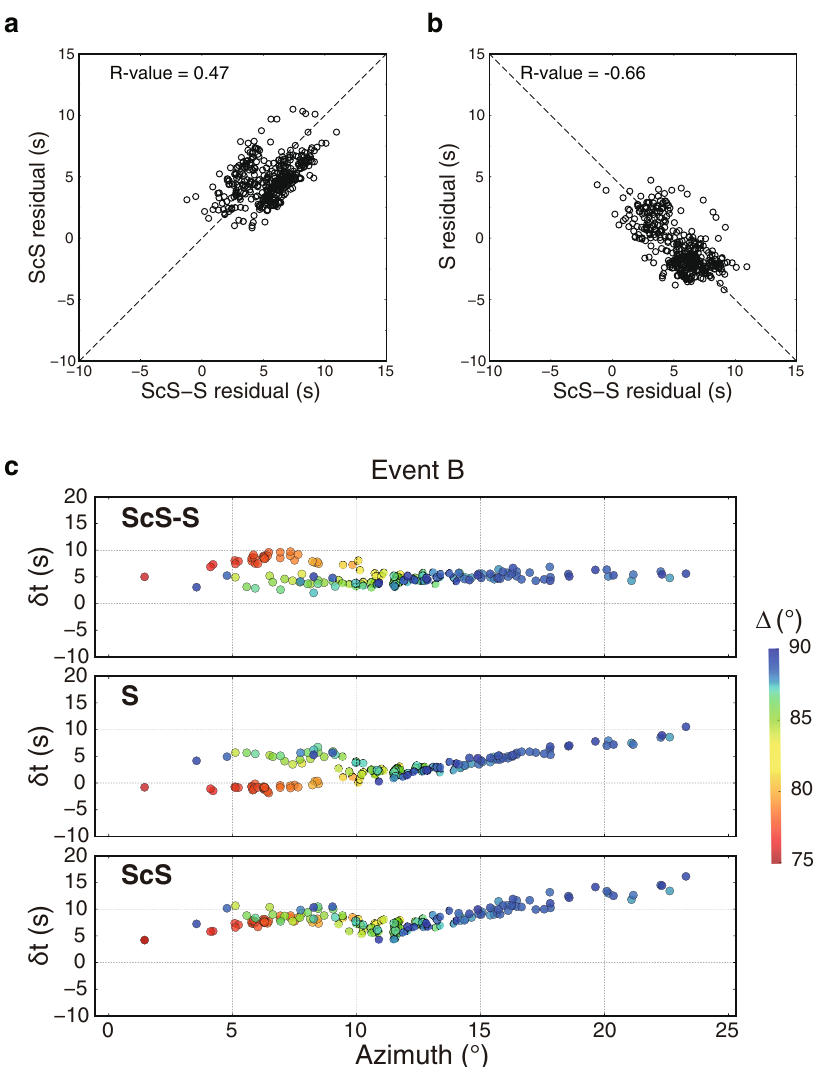
Fig. 2 Relationship between travel time residuals of S and ScS. The S/ScS travel time residuals ( δ t S / δ t ScS ) and differential travel time residuals between ScS and S ( δ t ScS-S ) are measured along the north-south pro fi le in Fig. 1a. a – b Results after correction for GyPSuM model 5 at a depth of 0 − 2000 km. Travel time residuals are corrected to a common station UNV to remove possible errors of event origin time and location. Pearson ’ s R-values quantify the correlations. c Azimuthal variation of travel time residuals ( δ t ScS-S , δ t S , and δ t ScS ) of event B with respect to the IASP91 velocity model 34 . The different color denotes the different epicentral distance. Note the large delay of S by up to 8 s from distance 75° to 90° at azimuths of 0°